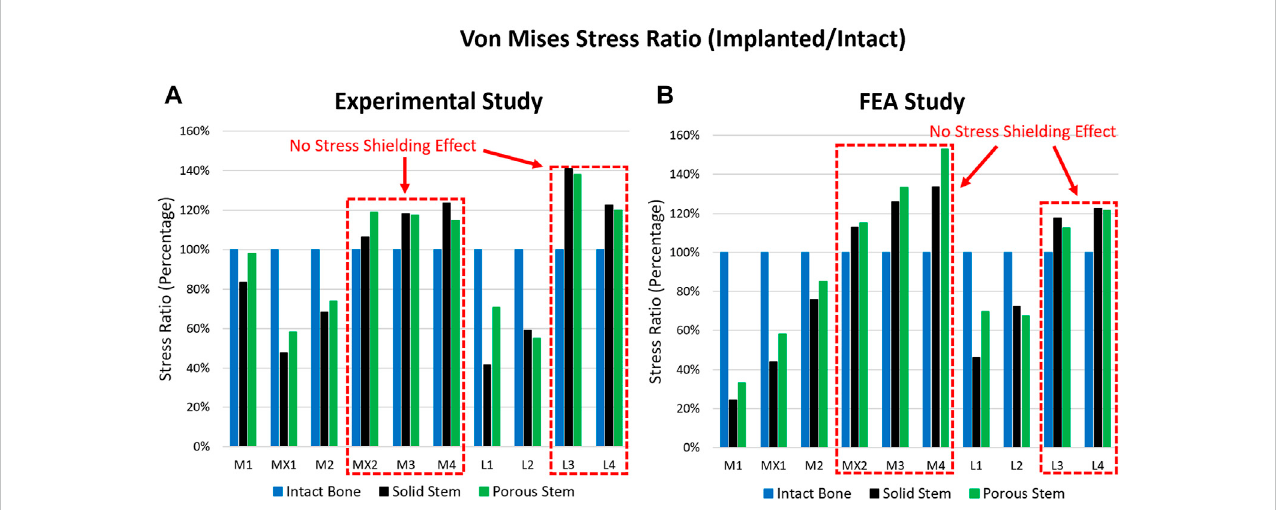
FIGURE 5 Stress ratio for 10 points of interest across the intact bone, solid stem, and porous stem, obtained through (A) experimental investigation, and (B) FE simulation.